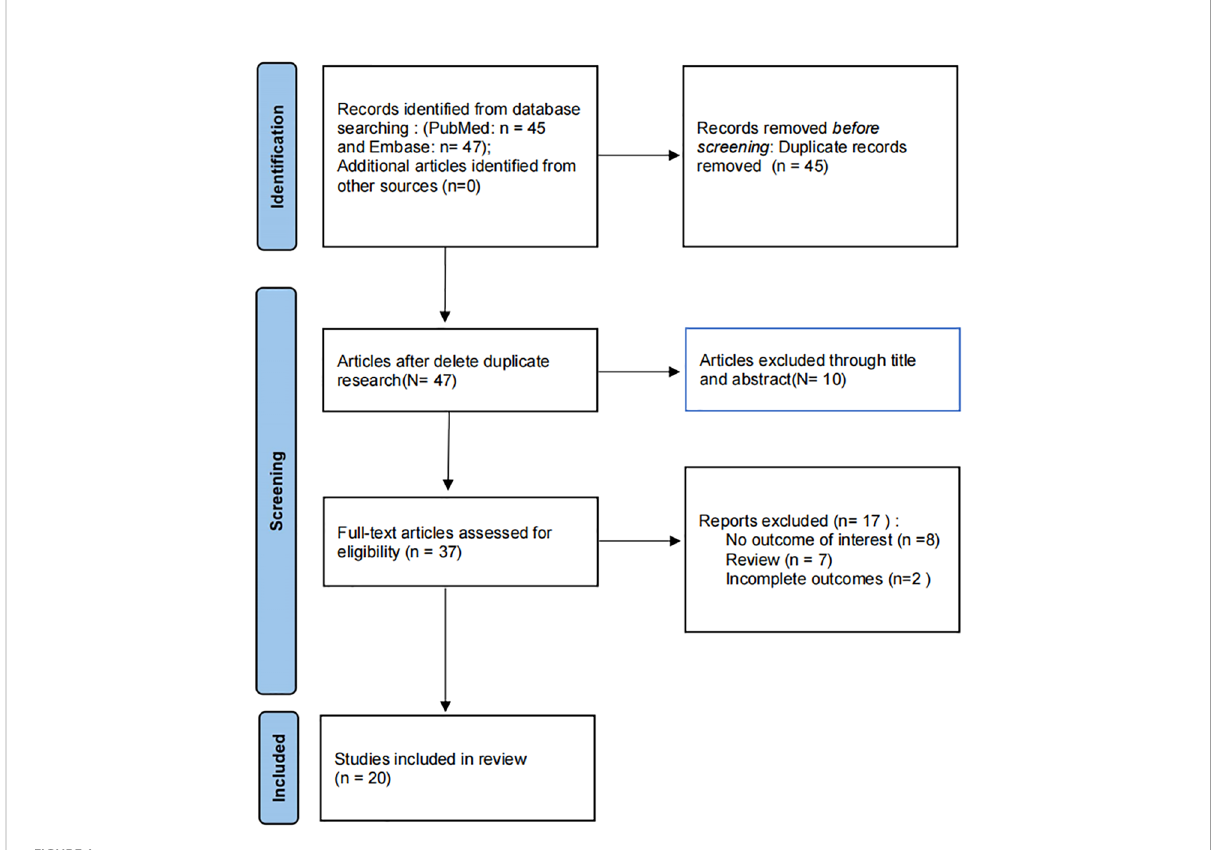
FIGURE 1 Flow diagram of systemic review